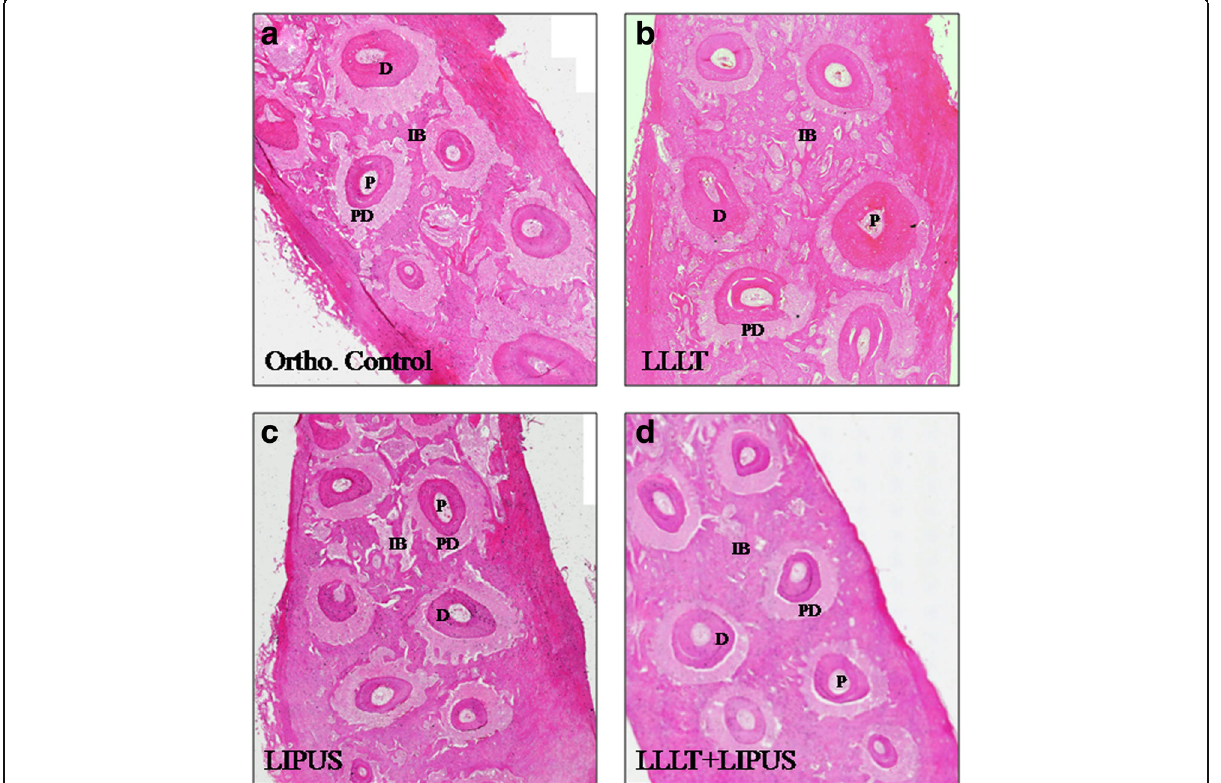
Fig. 7 Light micrographs of rat ’ s maxilla portions with orthodontically induced tooth movement for 21 days. There was higher amount of interseptal bone between the roots of the teeth in the treatment groups in relation to the orthodontic control group which also showed wider periodontal ligaments. Between the treatment groups, the interseptal bone was highest in the combination group, followed by the LLLT group and then the LIPUS group, sections stained with H&E. ×10. a Orthodontic control, b treated with 100 mW LLLT, c treated with LIPUS, and d treated with 100 mW LLLT + LIPUS. P : pulp, IB : interseptal bone, PDL : periodontal ligament, D :